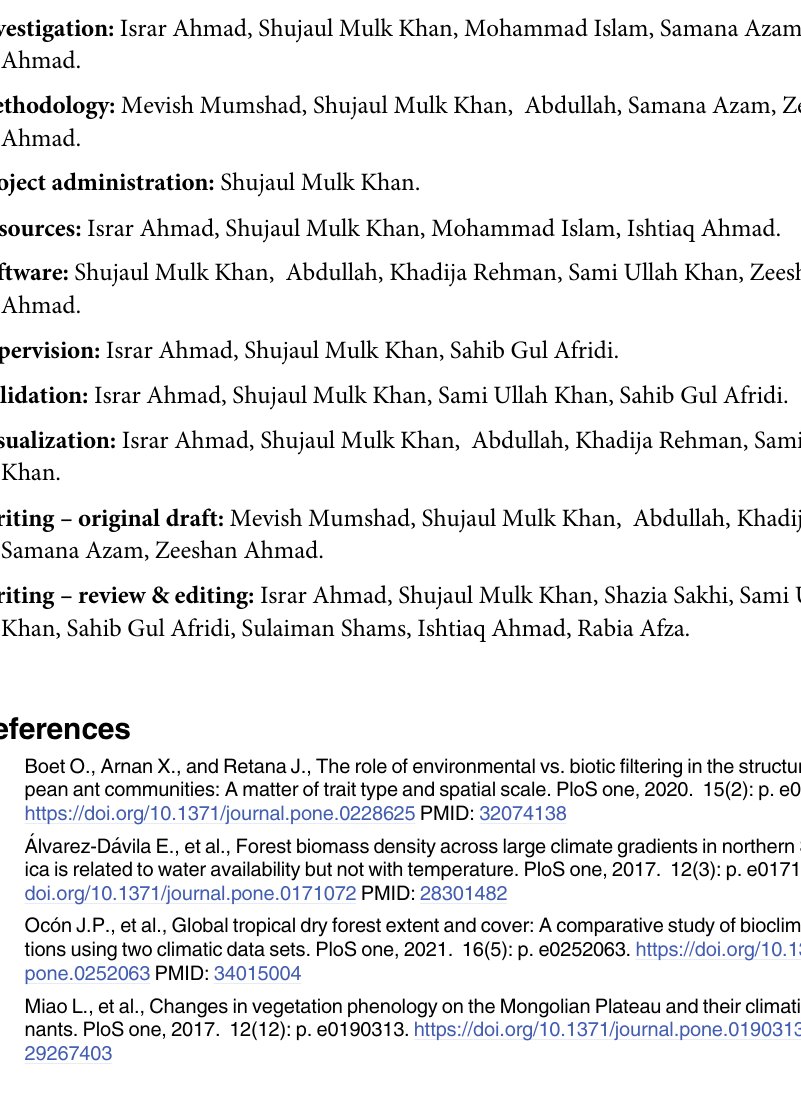
S1 Table. Detailed list of reported plant species along with their habit and family of